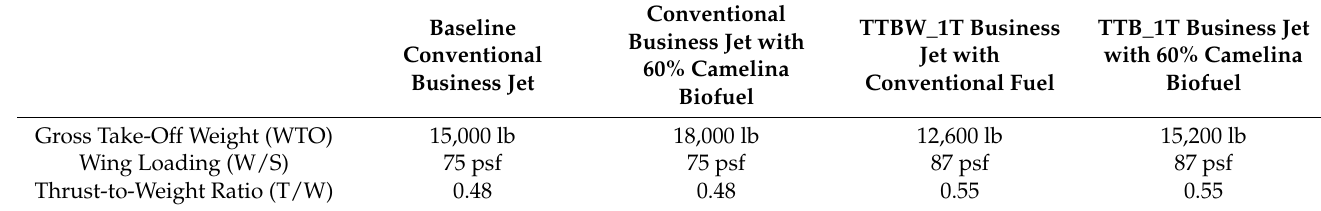
Table 7. The four selected design results.